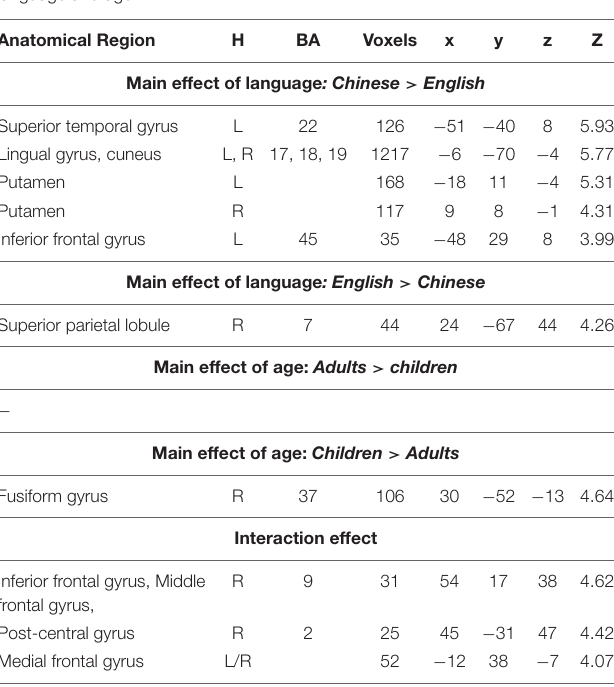
TABLE 2 | Brain regions that showed a significant main effect of language, a significant main effect of age, and a significant interaction effect between language and age.